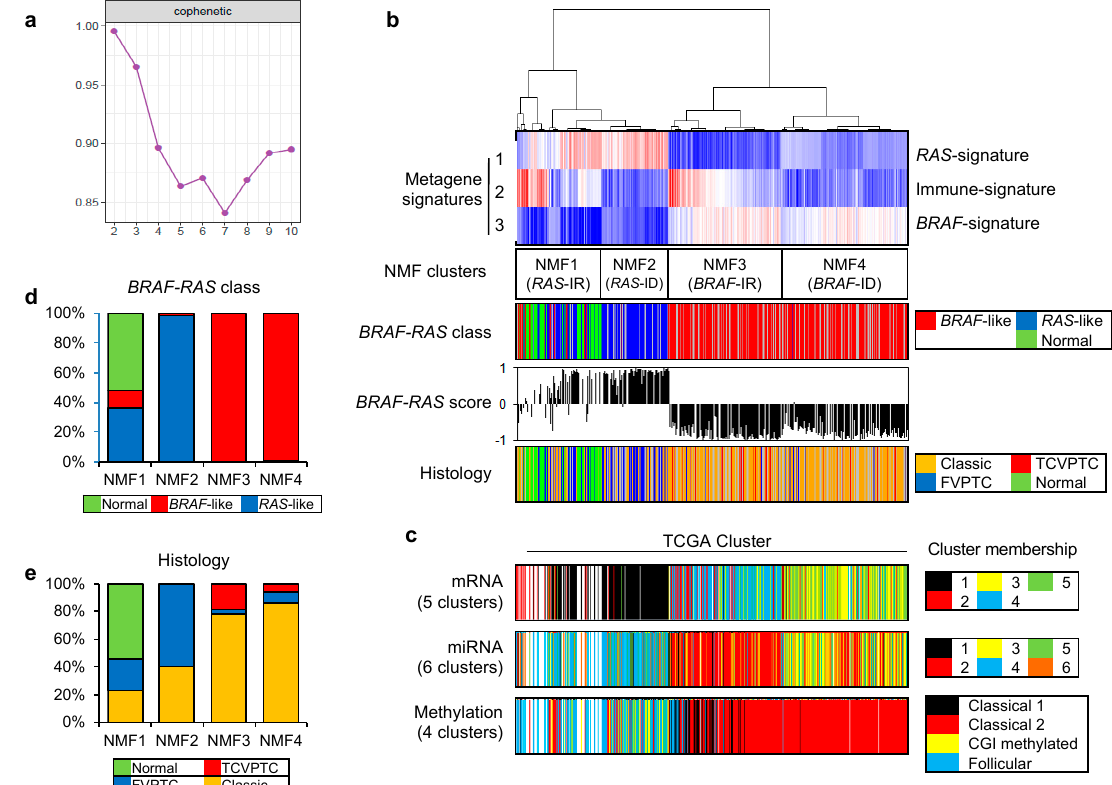
Figure 1. Gene expression profiles and non-negative matrix factorization (NMF)-driven metagene signatures of papillary thyroid carcinoma (PTC) in TCGA cohort. ( a ) Cophenetic correlation coefficients ( y -axis) plotted against the number of metagene signatures (2 to 10; x -axis). A drop in stability was marked between 3 and 4 metagene signatures, suggesting that at least three metagene signatures were present in TCGA PTC expression profiles; ( b ) TCGA PTC metagene expression profiles clustered according to levels of three metagene signatures (Metagene signatures 1–3; left , annotated as ‘ RAS -’, ‘Immune-’ and ‘ BRAF -signatures’, respectively) revealing four NMF clusters (NMF1–NMF4 corresponding to RAS -IR, RAS -ID, BRAF -IR, and BRAF -ID, respectively). In the heatmap, red and blue represent increased and decreased levels of metagene signatures, respectively. Also shown are BRAF-RAS classes and scores of individual PTCs available in TCGA consortium. Three PTC histological types are shown with normal thyroid epithelium; ( c ) Three PTC clustering schemes with respect to mRNA, miRNA, and DNA promoter methylation are shown as proposed by TCGA consortium; ( d ) Bar plots showing the proportion of BRAF -like and RAS -like PTC with normal thyroid across four NMF clusters; ( e ) PTC histology in four NMF clusters. TCVPTC = tall cell variant of PTC; FVPTC = follicular variant of PTC.